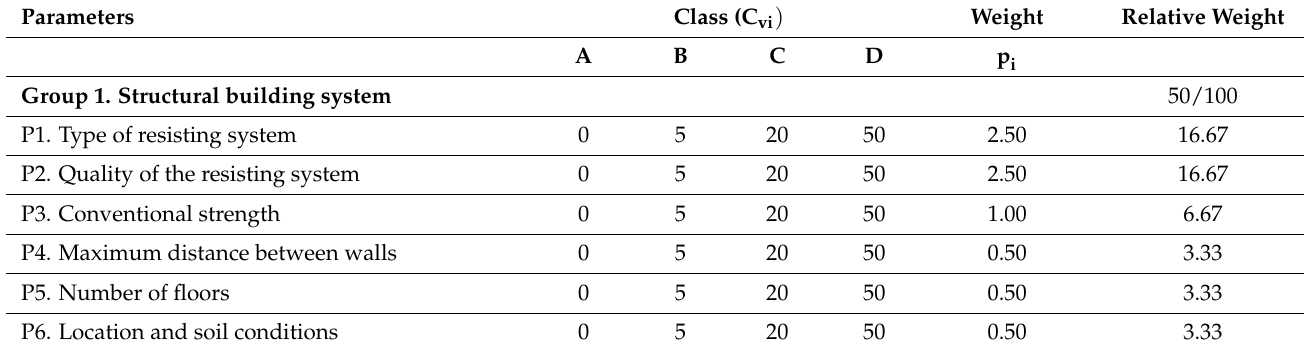
Table 4. Parameters, groups, and relative weights considered for the Building Approach,